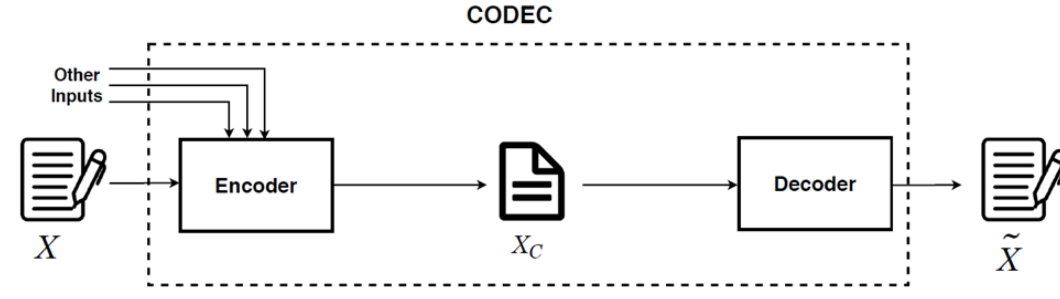
Figure 1. A schematic view of the desired